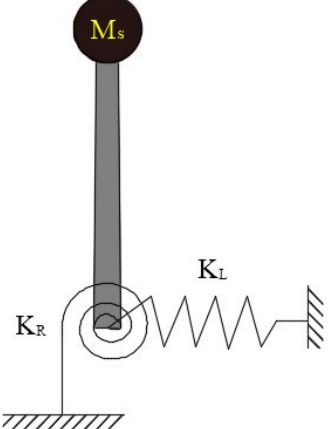
Figure 1. Simplified model of the tower system.